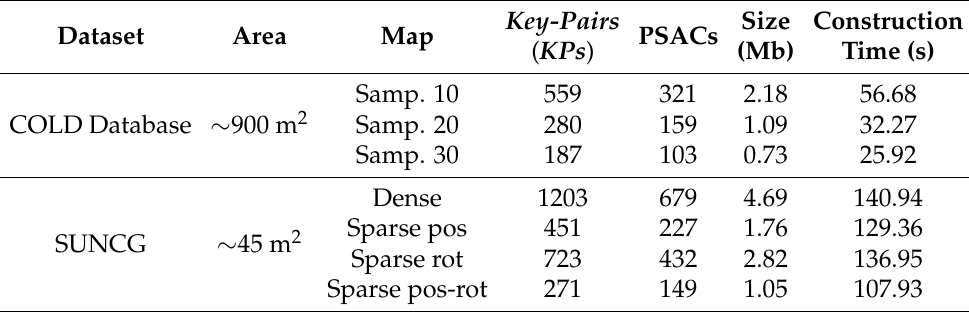
Table 1. Compared statistics of the created appearance maps. The dimension is calculated for a 2048-sized global